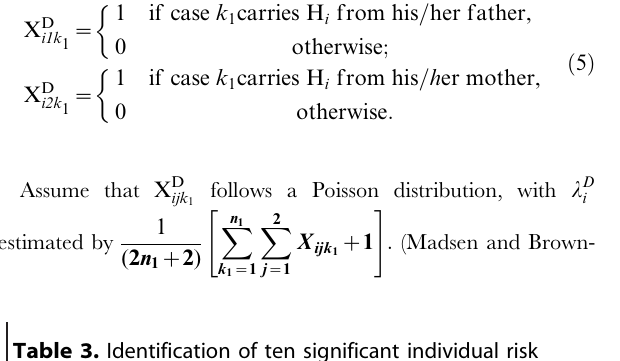
Table 3. Identification of ten significant individual risk variants ( P # 0.05) out of 183 rare variants using the SVM